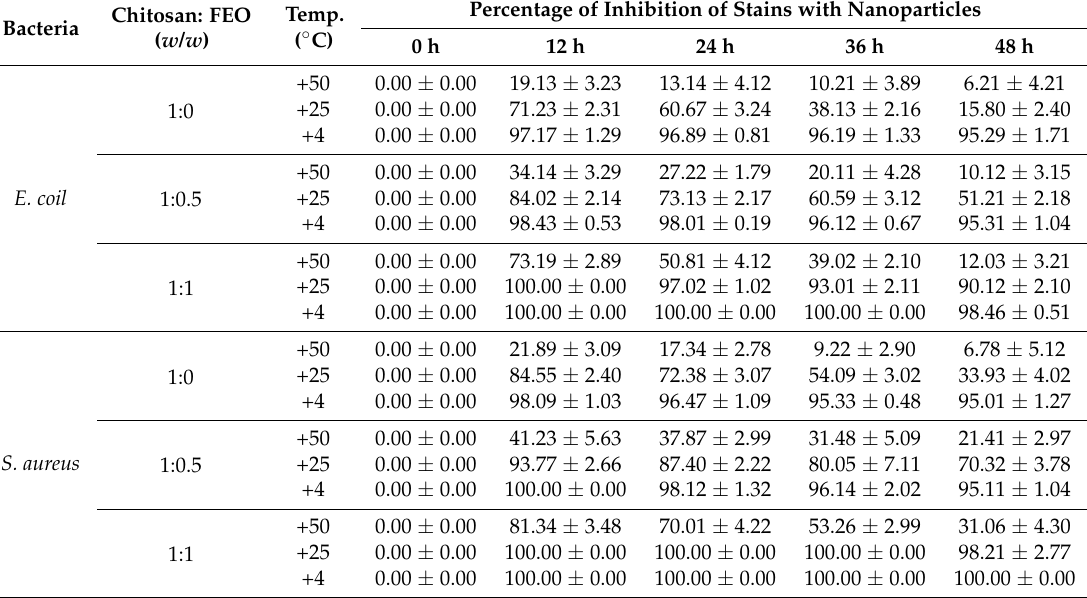
Table 3. Effects of FEO-loaded nanoparticles against E. coli and S. aureus